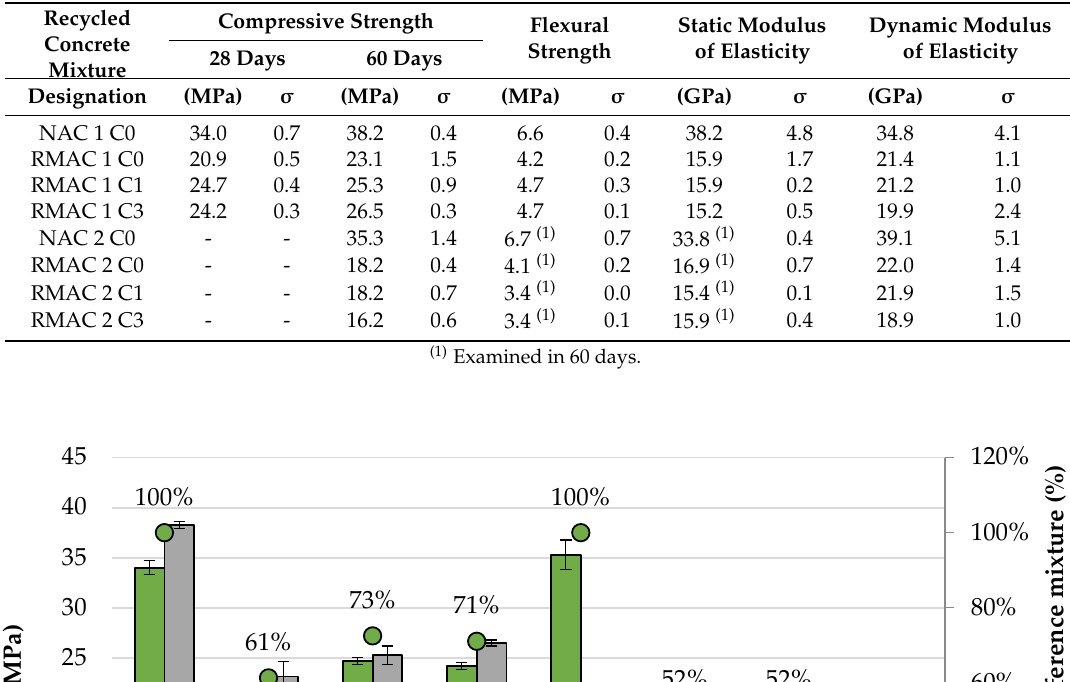
Table 4. Average values of results of mechanical properties of concrete, including standard deviation.